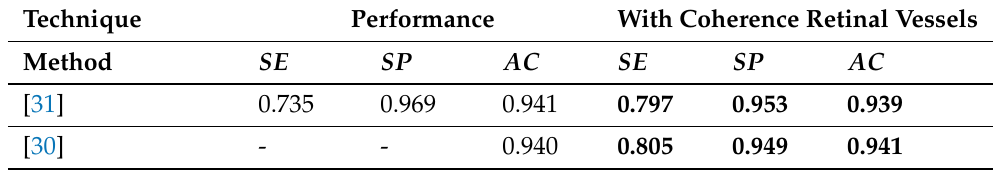
Table 3. The Impact of a Post-processing Module on Previous Techniques: DRIVE Dataset.